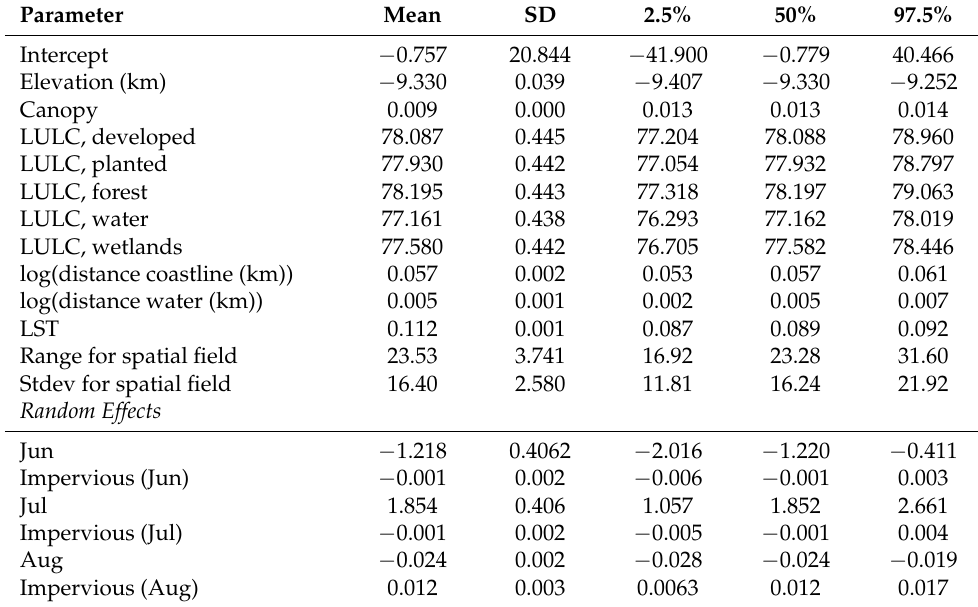
Table A3. Fitted model